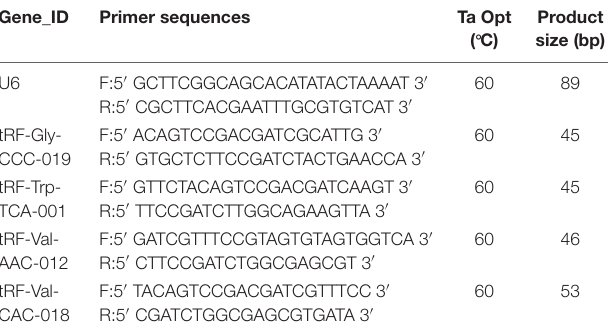
TABLE 3 | Sequences of primers for